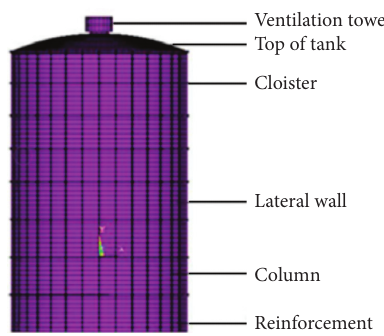
Figure 1: Geometry model of the gas tank. Table 1: Aerodynamic regimes and flow characteristics around a circular cylinder. Data from Wieselsberger [2]; Schewe [3]; Williamson